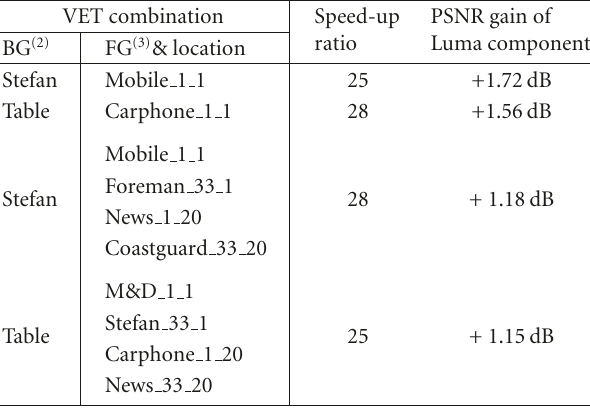
Table 6: Improvement of execution time and quality as compared to CPDT. (1)